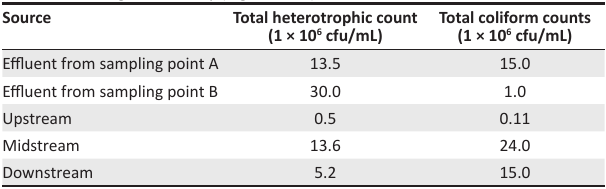
TABLE 1: Mean total heterotrophic and coliform counts of the abattoir effluents and its receiving water body (Ogun River). Source